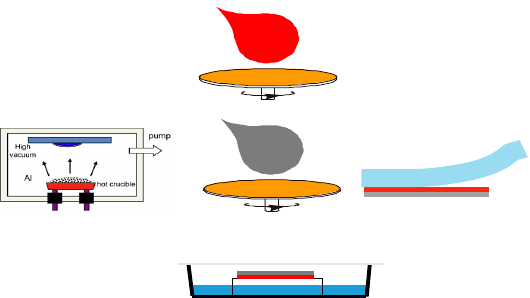
Figure 1. Experimental scheme of solvent vapor-induced interdiffusion in donor/acceptor. The bilayer samples were prepared by spin-casting of the first layer followed by: thermal evaporation, subsequent casting from orthogonal solvent, or transfer with PDMS of the second layer. The samples were then transferred to a sealed container partially filled with a solvent.